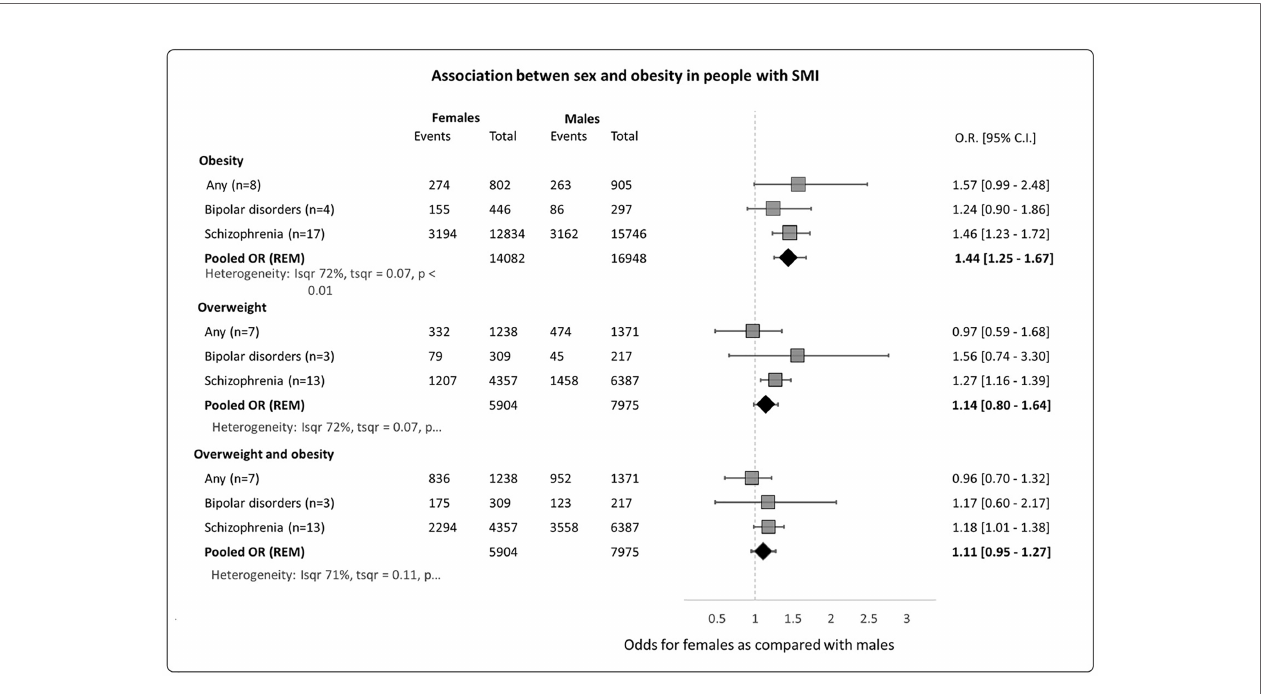
FIGURE 6 | Association between sex and obesity in people with